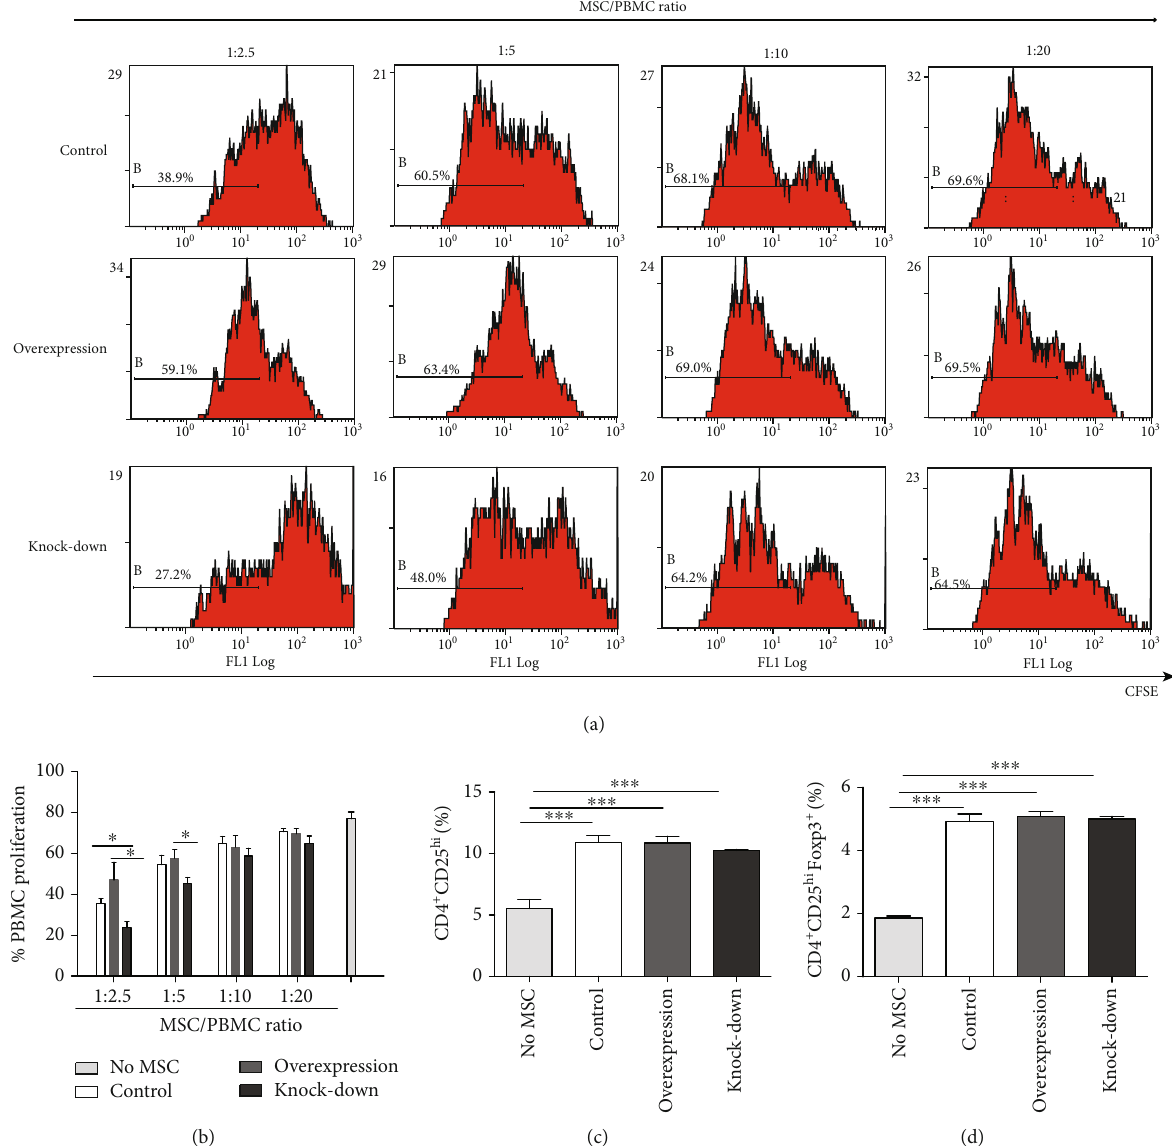
Figure 6: Immunosuppressive functions of BM-MSCs. (a – b) The result of fl ow cytometry analysis showing the e ff ect of three groups of BM- MSCs on the proliferation of PHA-activated PBMCs. PBMCs were cocultured with di ff erent ratios of BM-MSCs for 5 days. (c – d) The proportion of CD4 + CD25 high cells and CD4 + CD25 + Foxp3 + cells in the gate of CD4 + cells. All experiments were repeated at least three times. Data are presented as mean ± SD . ∗ p < 0 : 05 , ∗∗∗ p < 0 : 001